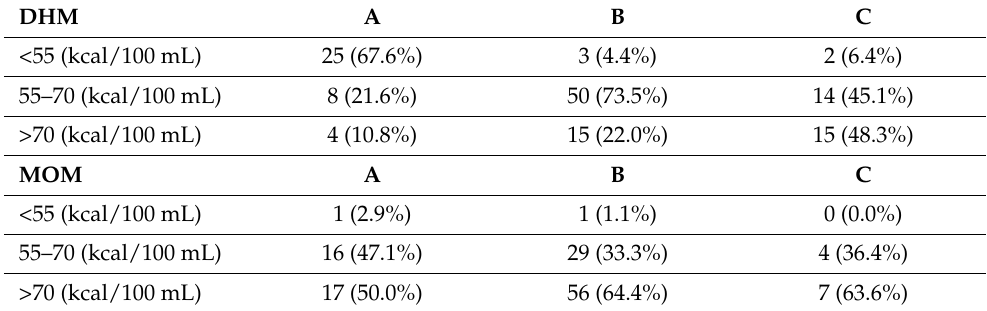
Table 3. Classification of milk samples based on calorie content and assigned color